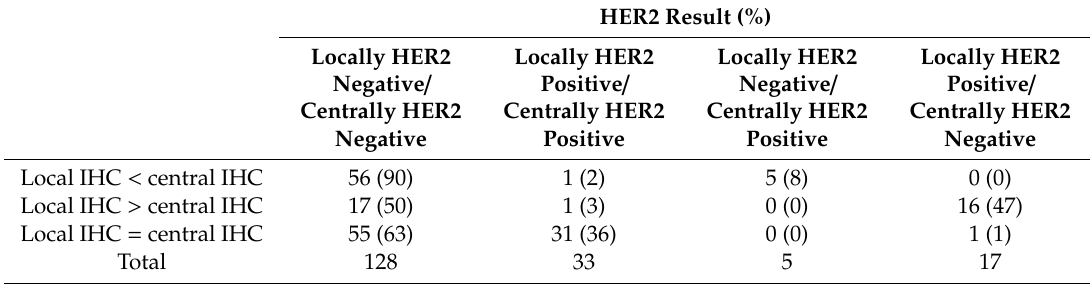
Table 3. Comparison of local and central HER2 IHC result and impact on HER2 status.